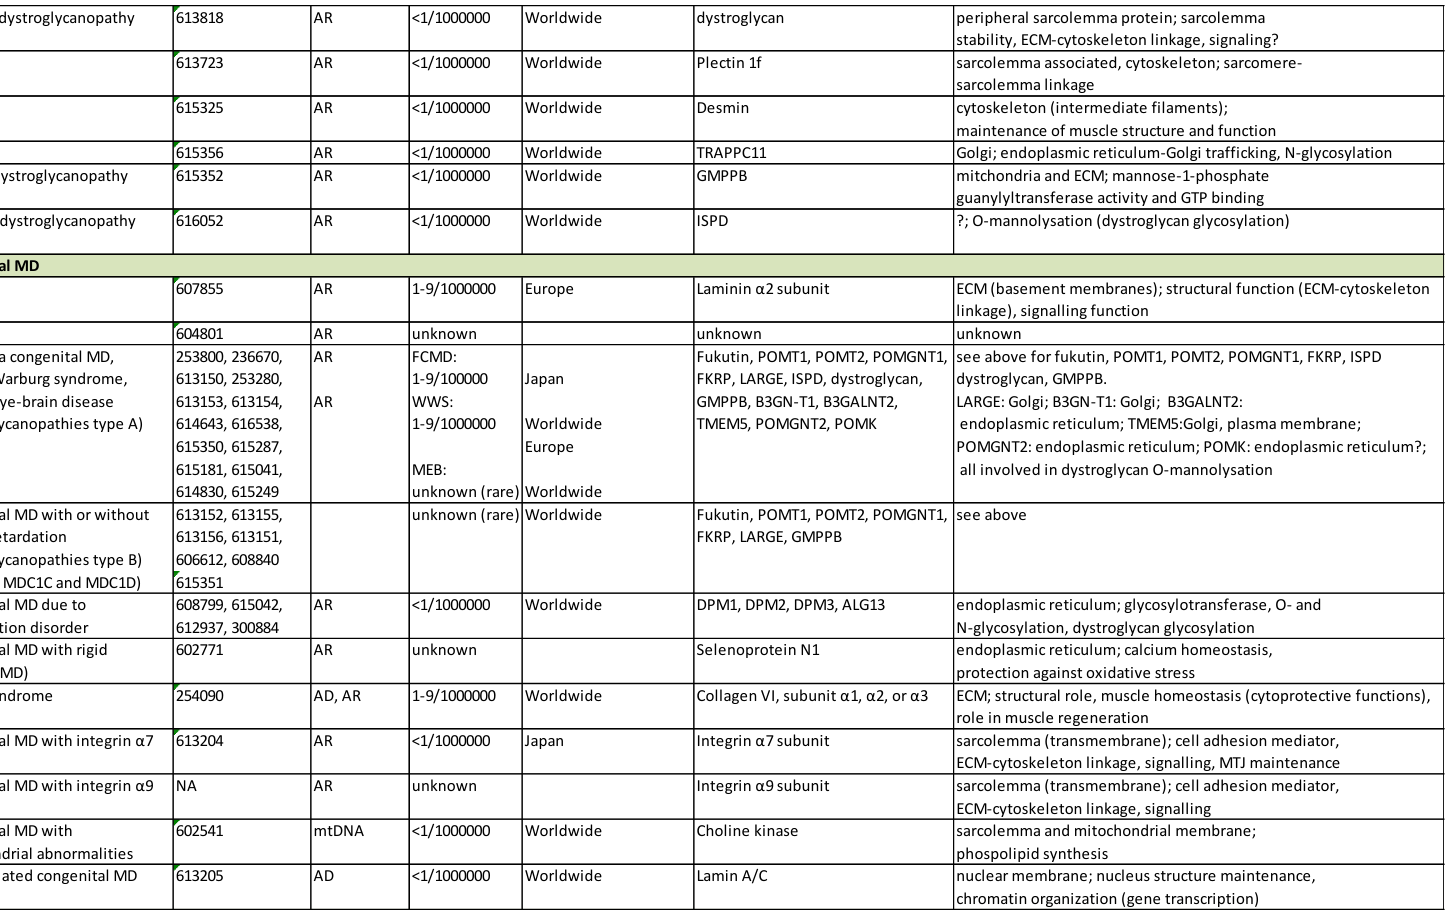
Table 1. Cont. Int. J. Mol. Sci. 2018 , 19 , x FOR PEER REVIEW 4 of